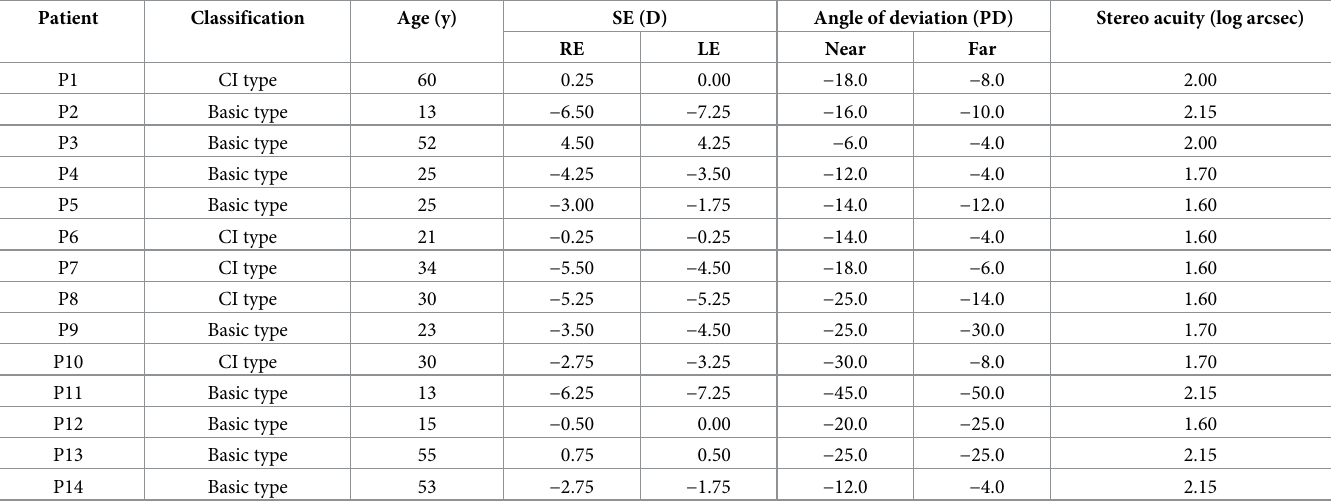
Table 1. Demographics of the intermittent exotropia (IXT)